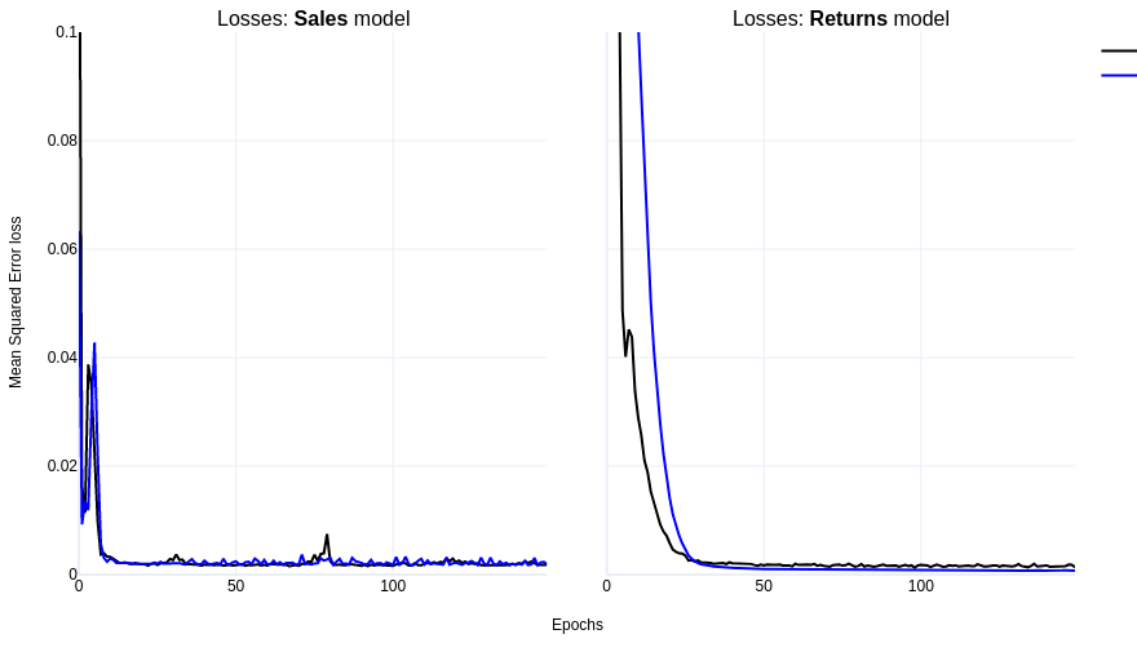
Figure 5. Loss curves for the sales and returns models. Carrying out a partial model test to verify intended rationality [56] by embedding